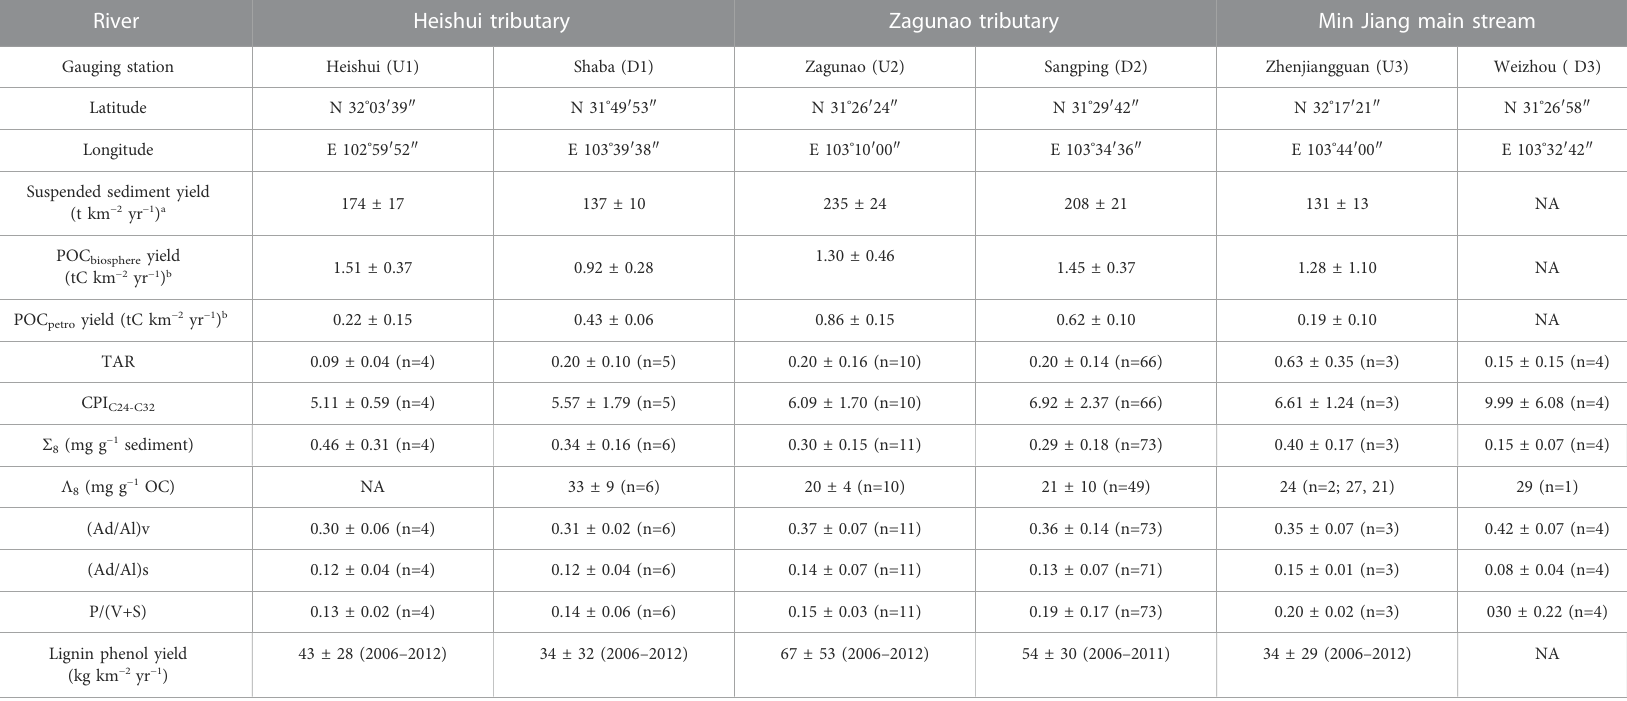
TABLE 1 Characteristics of gauging stations in the upper Min Jiang and estimates of sediment, POC and lignin phenol yield at each